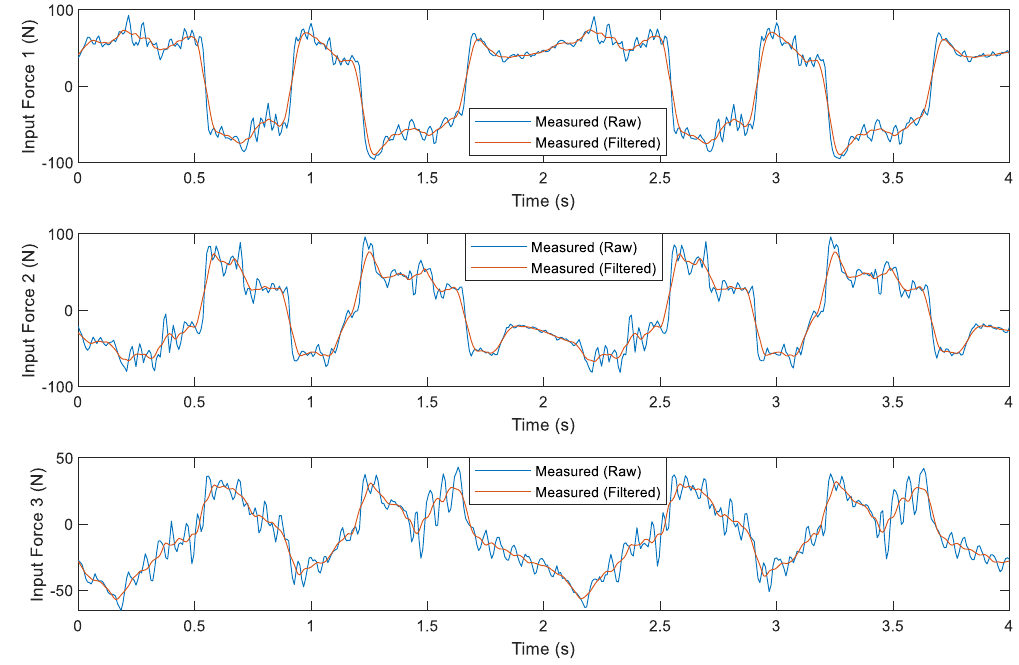
Figure 11. Raw and filtered measured input forces.